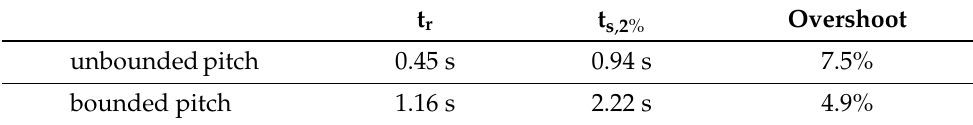
Figure 5. Euler angles ( top ), inertial velocities ( bottom left ) and altitude change ( bottom right ) with MPC, adding bounds on pitch and using the corrected objective function in (12). Table 2. Representative values of height control for modified MPC.